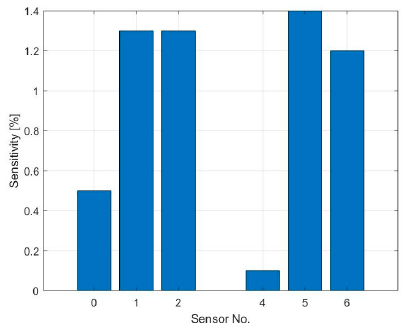
Figure 11. Summary of the sensitivity towards 10 ppm of NH 3 of sensors S 0 , S 1 , S 2 , S 4 , S 5, and S 6 .